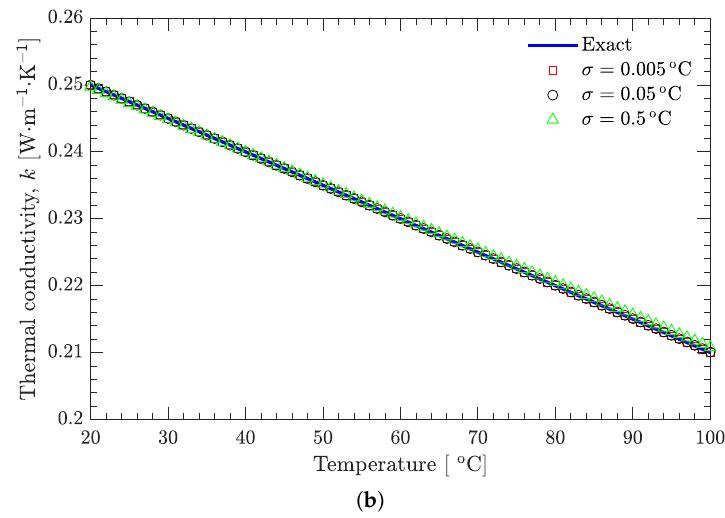
Figure 5. Effect of random noise on the recovered temperatures and on the estimated thermal conductivity; a linear function of k ( T ) is prespecified. ( a ) Temperature. ( b ) Thermal conductivity.